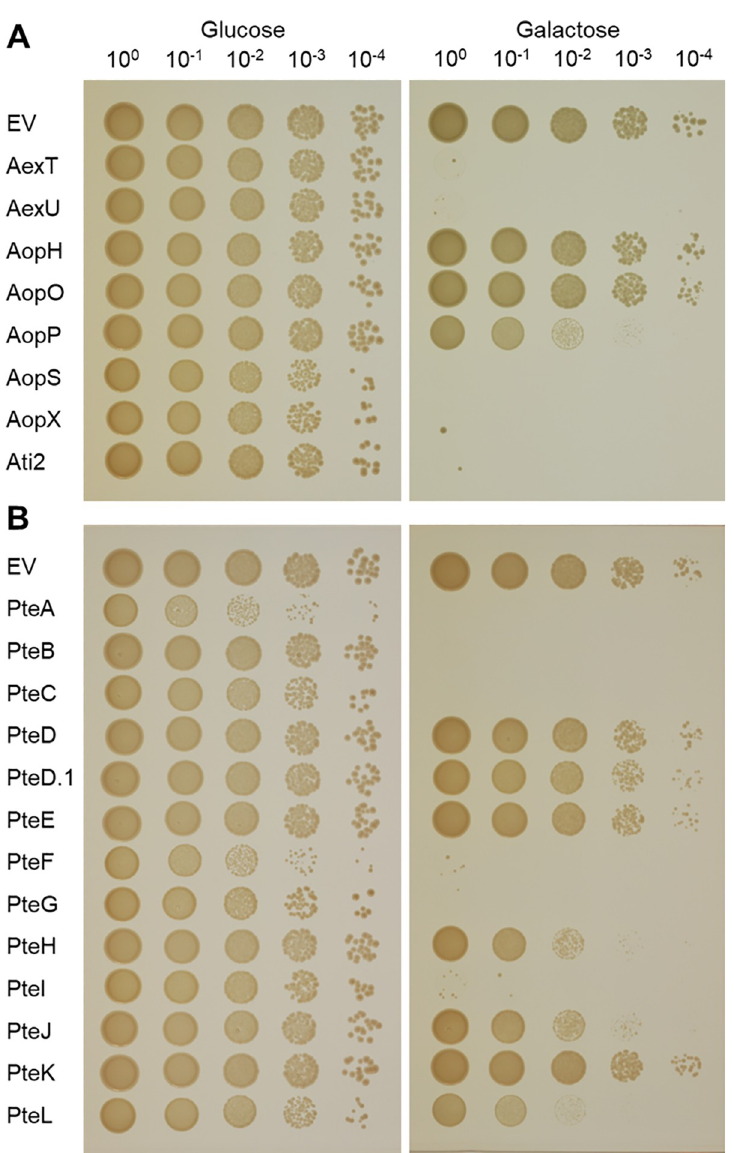
Fig 2. Yeast growth inhibition assay. Strains carrying putative T3SS effectors cloned into pGREG533 were cultured overnight in SDM-His-Glu, washed and 10-fold serially diluted. Aliquots from each dilution (10 μ l) were spotted onto SDM-His-Glu and SDM-His-Gal plates. A strain containing pGREG533 was used as a negative control and showed no growth inhibition. SDM-His-Glu and SDM-His-Gal plates were incubated at 30˚C for 2–3 days. T3SS effectors previously identified or biochemically characterized are presented in panel (A), whereas those identified in the present study are shown in panel